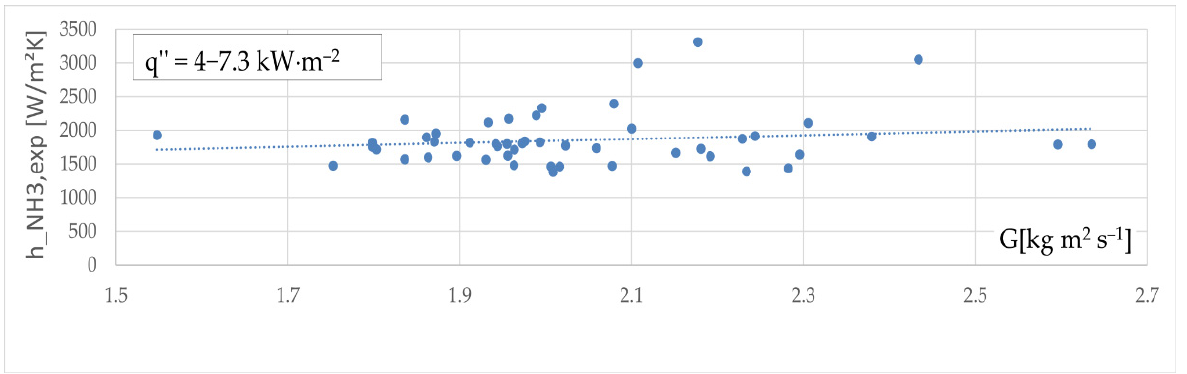
Figure 8. Experimental heat transfer coefficient vs. mass flux.